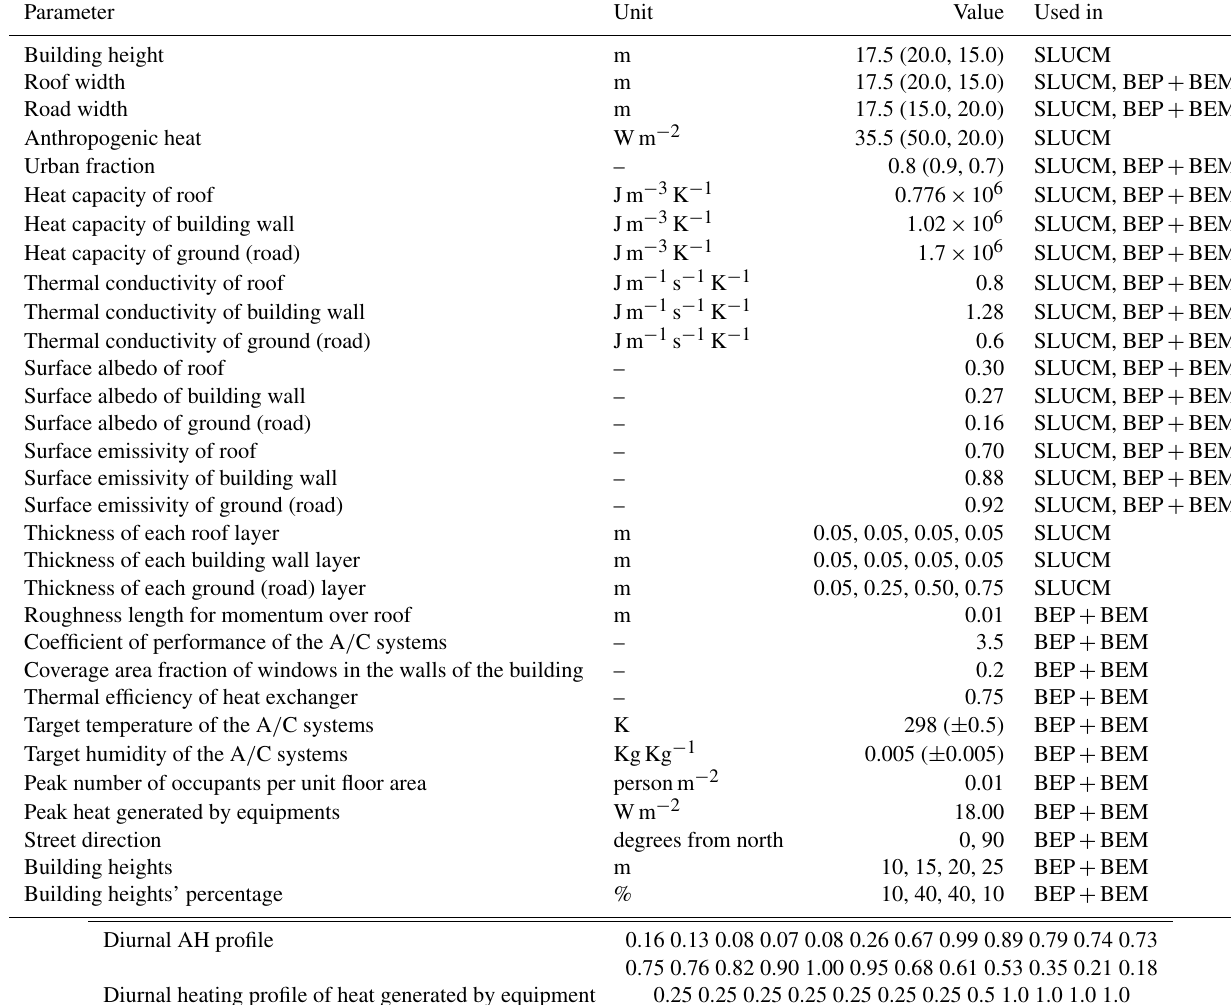
Table 1. Urban canopy parameters used in simulations. Values in brackets indicate different parameters used in RegCM simulations with the SLUCM scheme, in which urban and suburban categories are considered.